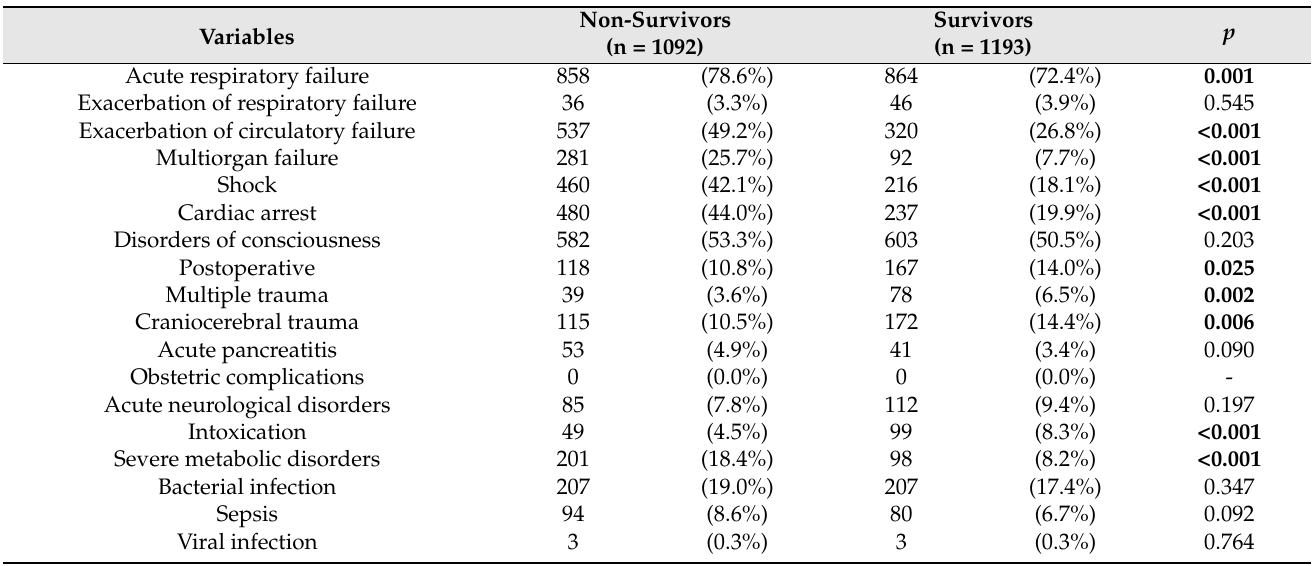
Table 5. Primary reasons for ICU admission among patients with AD—comparison of non-survivors and